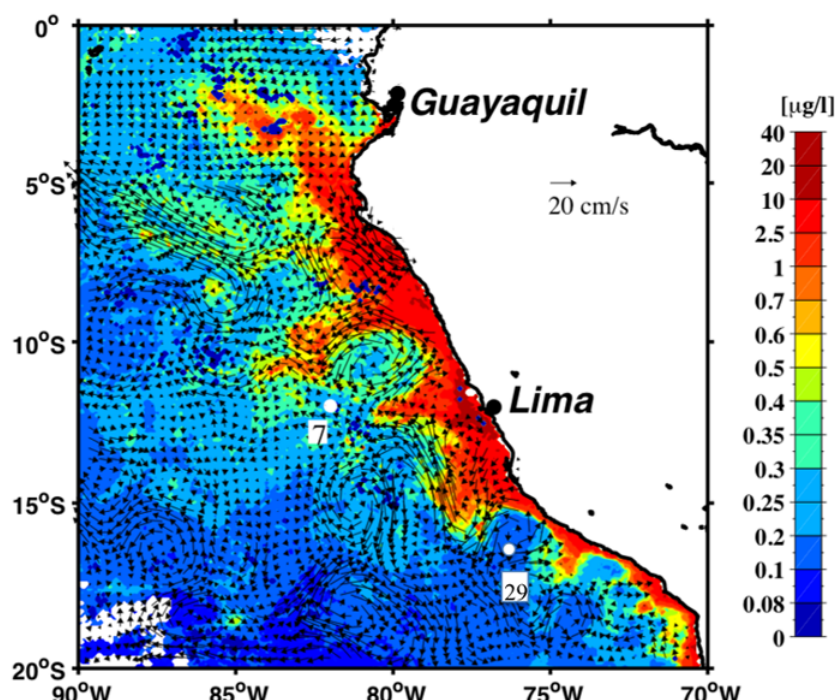
Fig. 5. Satellite observations for the period when Station 7 was occupied (location as indicated). Sea surface chlorophyll (SSC; µgl − 1 ) for January 2009 is overlaid by current vectors derived from sea level anomaly (SLA) for 7 January 2009. SSC reflects surface ocean phytoplankton concentration and productivity and was available from the NASA Giovanni website (http://gdata1.sci.gsfc.nasa.gov) as a monthly average. SLA and related current vectors vary in response to barotropic velocity variation from the mean state and is available from the AVISO website (http://www.aviso.oceanobs.com) representing the sea state for a given